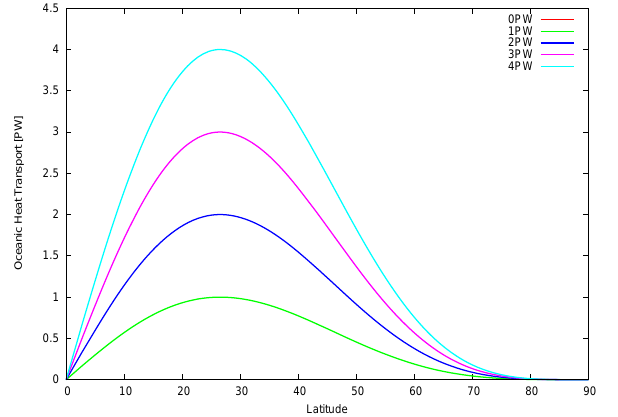
Figure 1. Oceanic heat transport (in PW) for OHT max = 0, 1, 2, 3, and